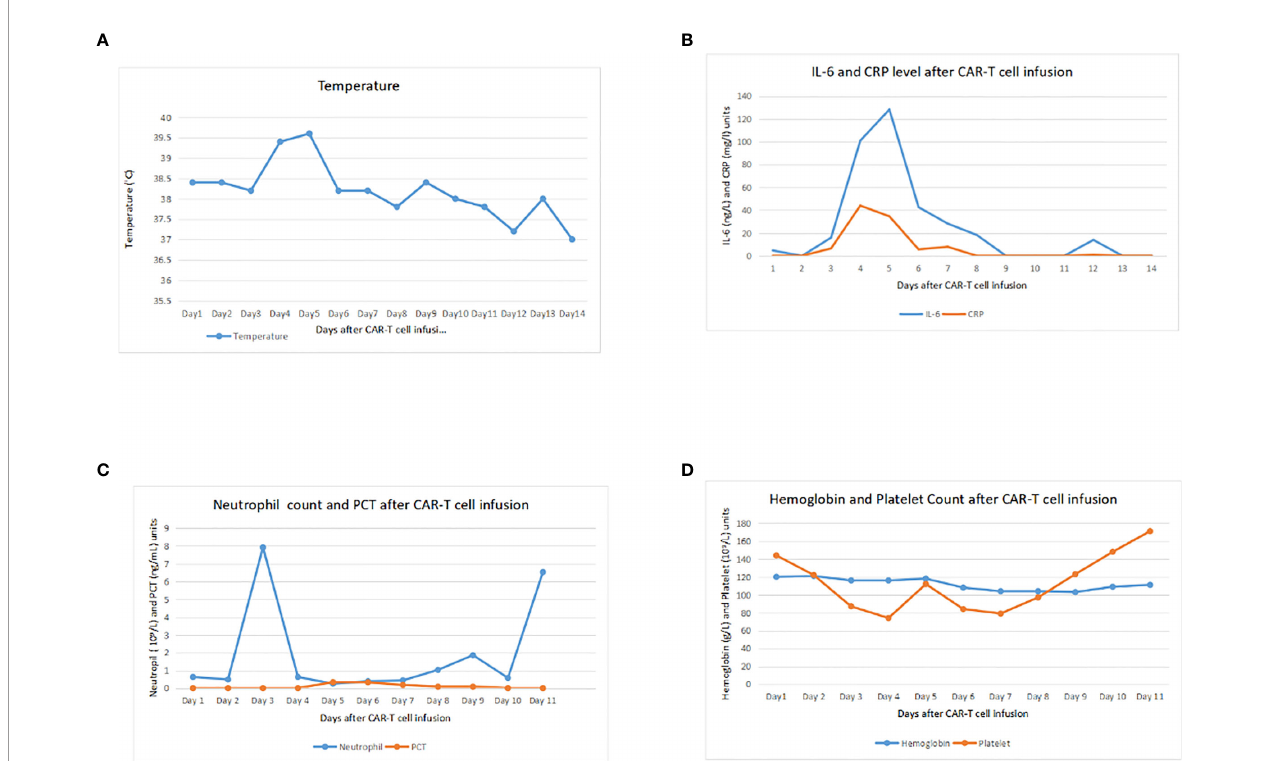
FIGURE 2 | Clinical monitoring after infusion of pCDH-CD19-CAR cells. (A) Trends of temperature during 14 days after infusion. (B) Trends of interleukin (IL)-6 and C-reactive protein (CRP) during 14 days after infusion. (C) Changes of neutrophil count and procalcitonin (PCT) during 14 days after infusion. (D) Changes of hemoglobin (Hb) and platelet (PLT) during 14 days after